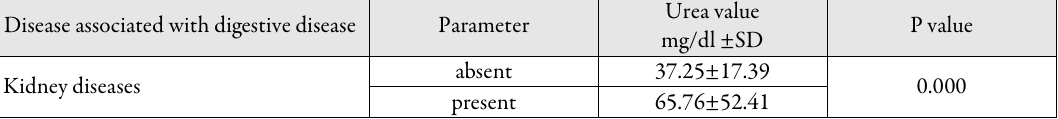
Table 2. Average values of blood urea in the target group for renal disease in comorbidity, at admission Disease associated with digestive disease